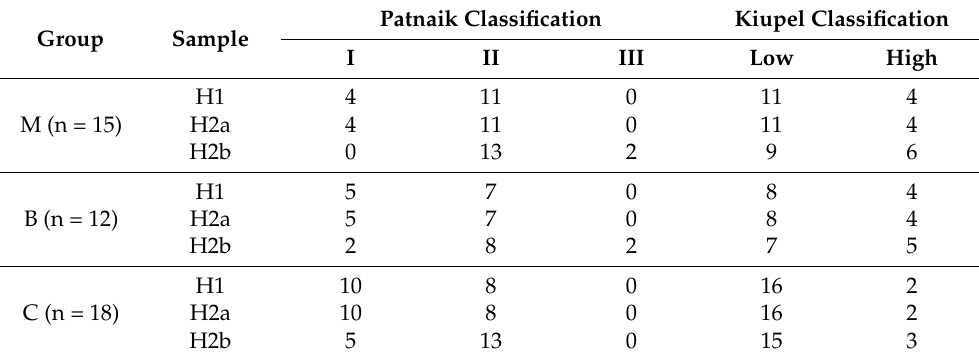
Table 3. Histopathologic grading for Patnaik’s and Kiupel’s systems allocated in samples H1, H2a and